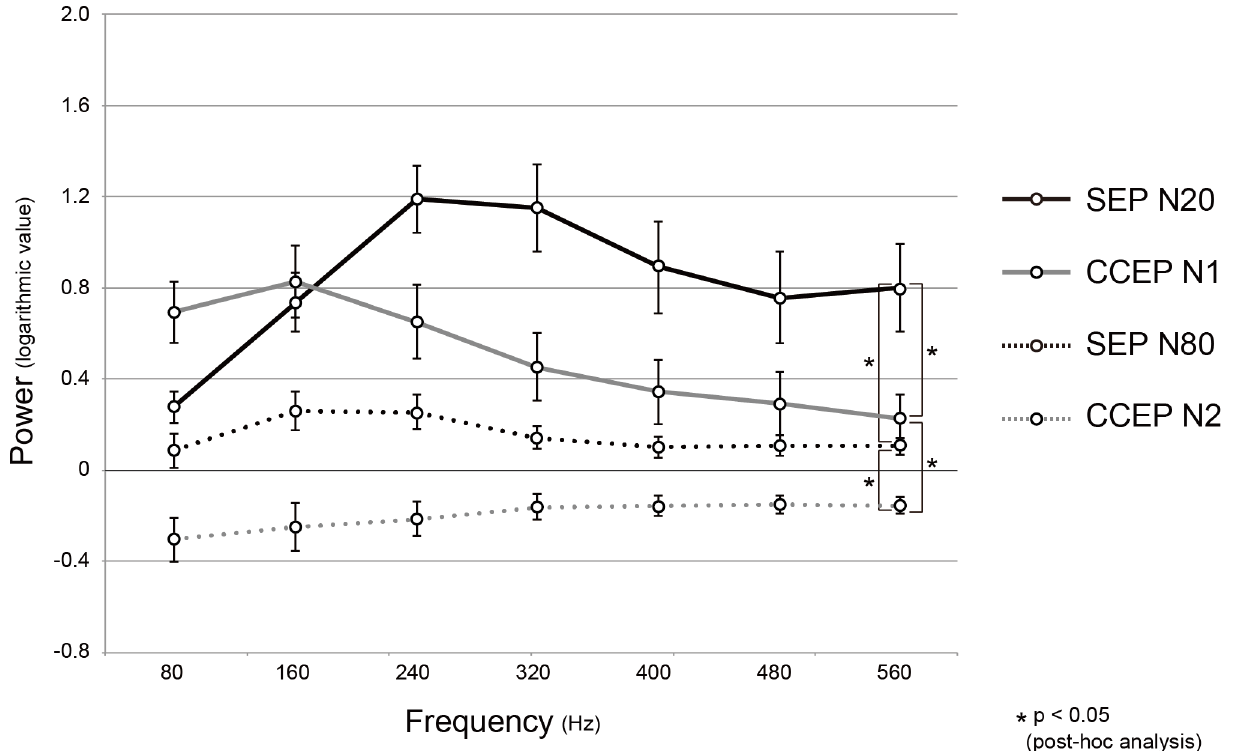
Fig 4. The distributions of logarithmic power values in reference to the baseline in each frequency band. As for the 4 groups, HFA SEP(N20) (a black solid line), HFA CCEP(N1) (a grey solid line), HFA SEP(N80) (a black dashed line) and HFA CCEP(N2) (a grey dashed line), all the power values of 7 hemispheres are averaged (mean ± SE). RM-ANOVA showed statistically significant interactions between the 4 groups. An asterisk indicates significant interaction between the 2 groups in the post-hoc analysis. Other conventions are the same as for Fig